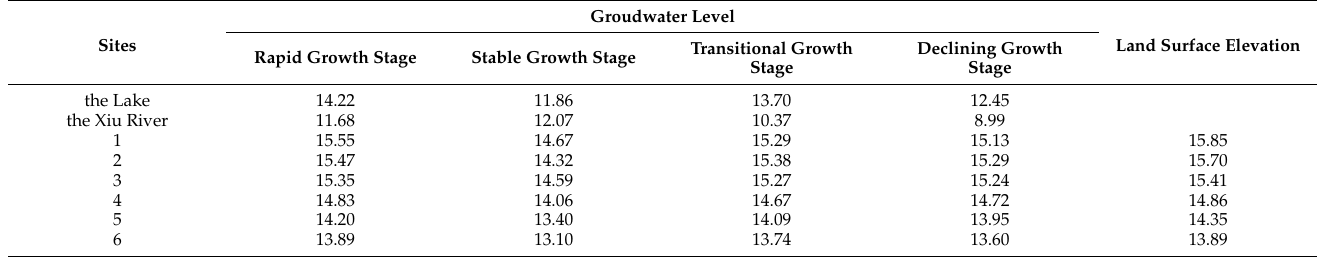
Table 1. Water–levels in the river and the lake and groundwater tables of the sample sites in different growth